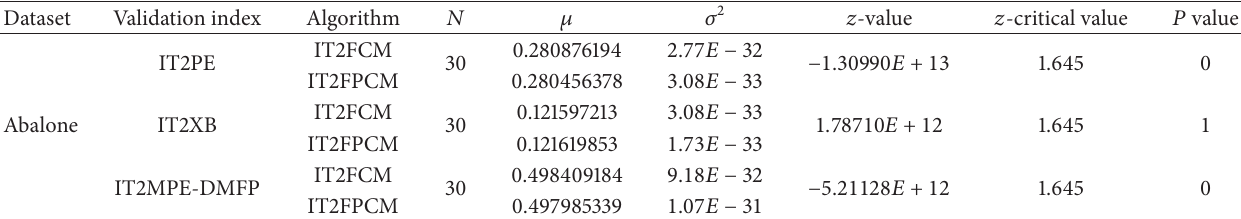
Table 20: Hypothesis test for IT2PE, IT2XB, and IT2MPE-DMFP indices of validation for the Abalone dataset clustering.